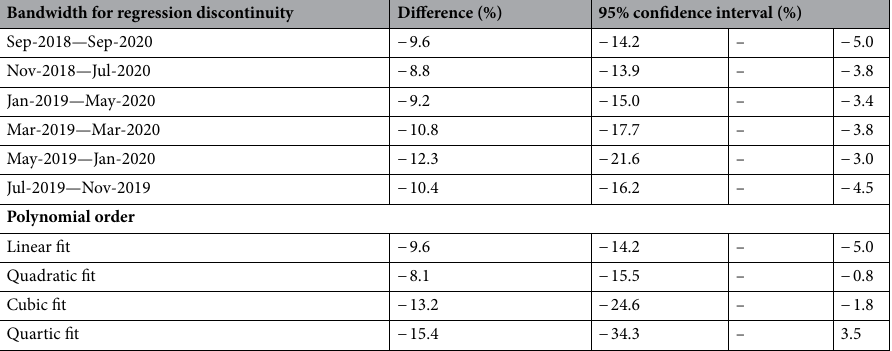
Bandwidth for regression discontinuity Difference (%) 95% confidence interval